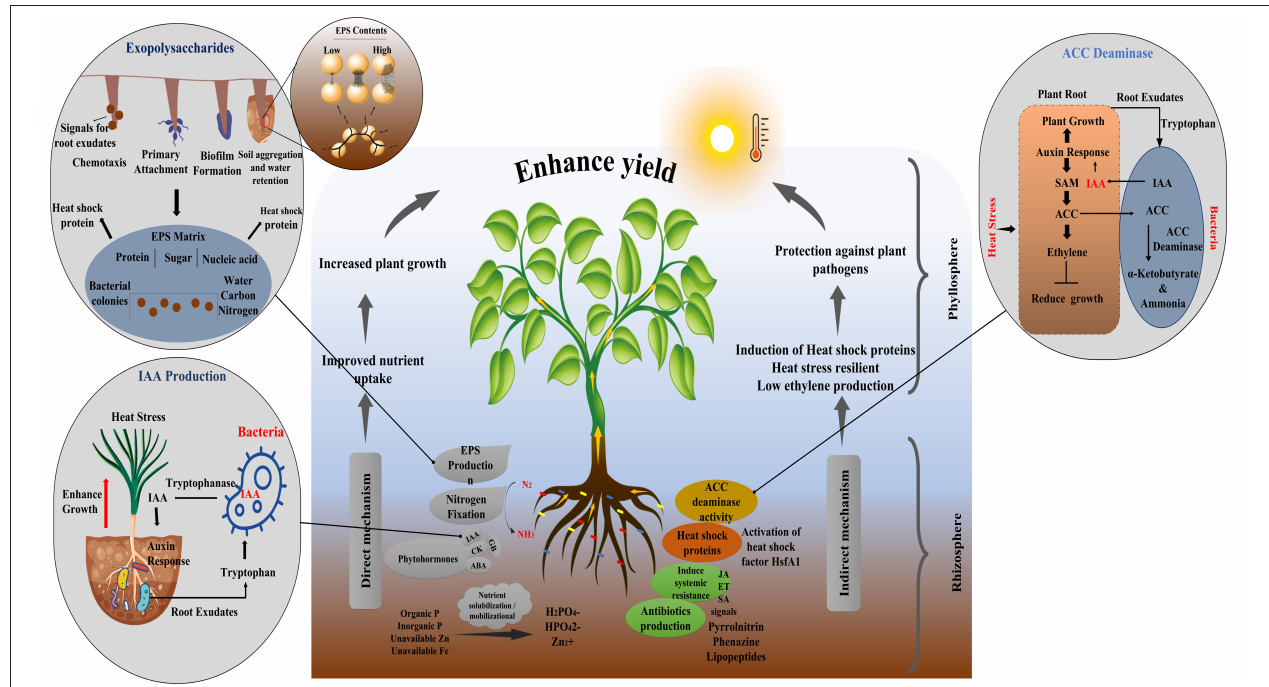
FIGURE 4 | Mechanism of PGPR for growth promotion and a(biotic) stress